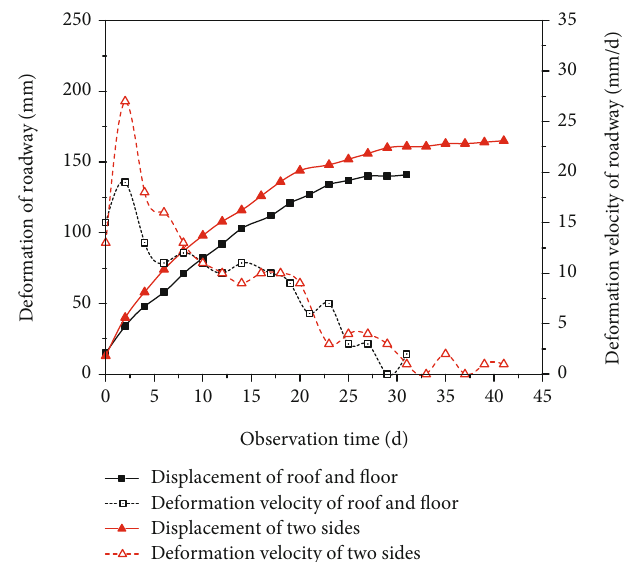
Figure 12: Surface displacement